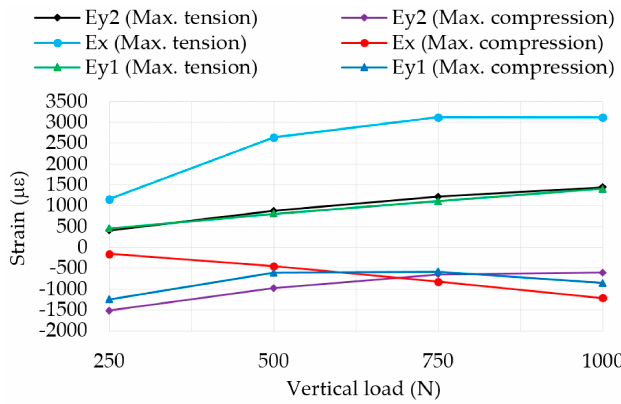
Figure 10. Influence of vertical load at 1 bar, 30 km/h.